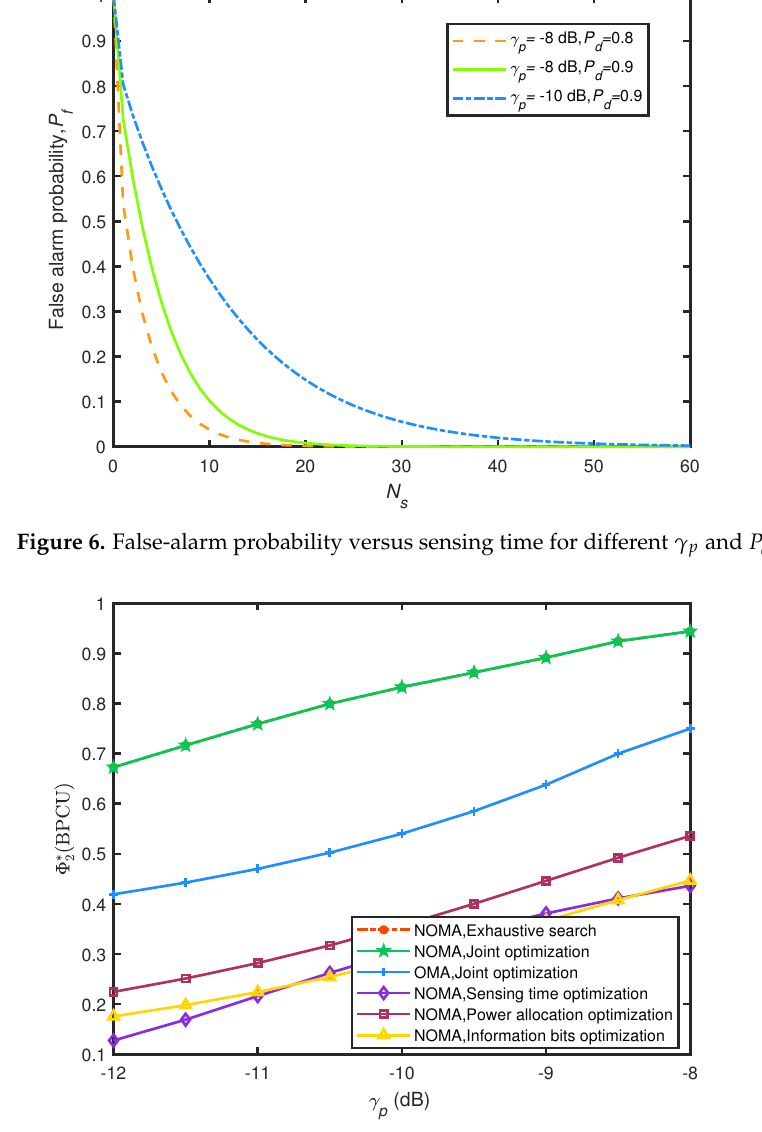
Figure 7. Performance comparison for different algorithms and